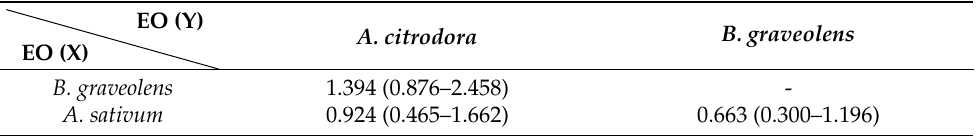
df = 14, p < 0.001. Table 3. Relative toxicity of Aloysia citrodora , Bursera graveolens , and Allium sativum essential oils (EOs) to eggs of the blowfly Calliphora vomitoria.